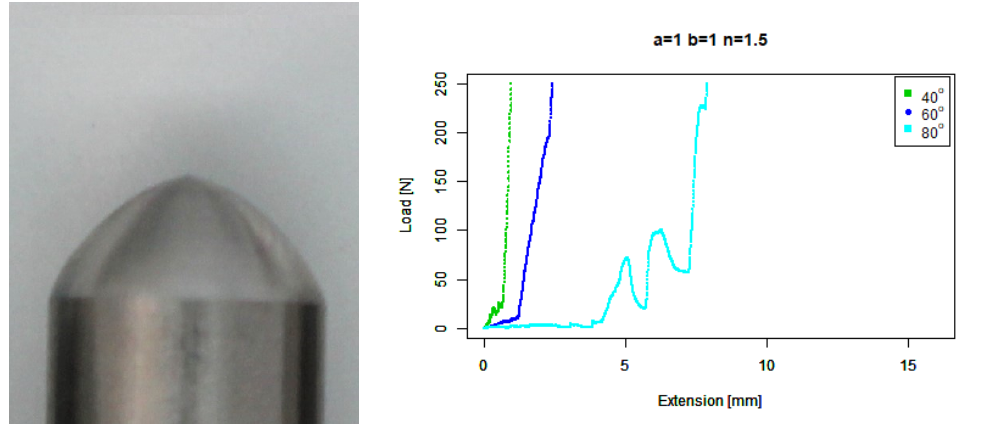
Figure 11. Basic convex tip. ( Left ) Tip Profile. ( Right ) Experimental characterisation.